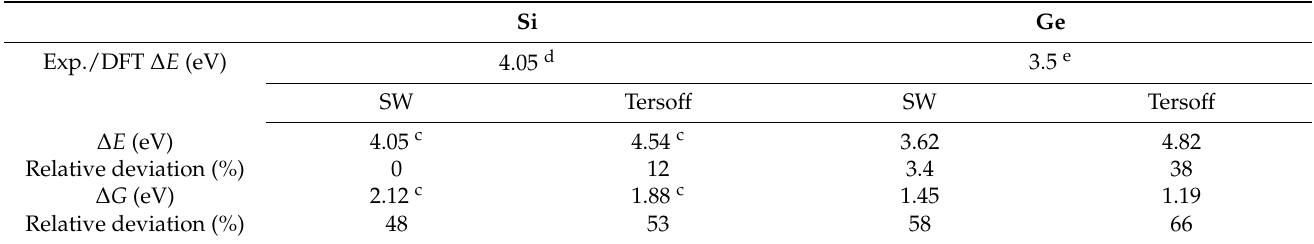
Table 3. Formation energies of interstitial in silicon and germanium at T m .